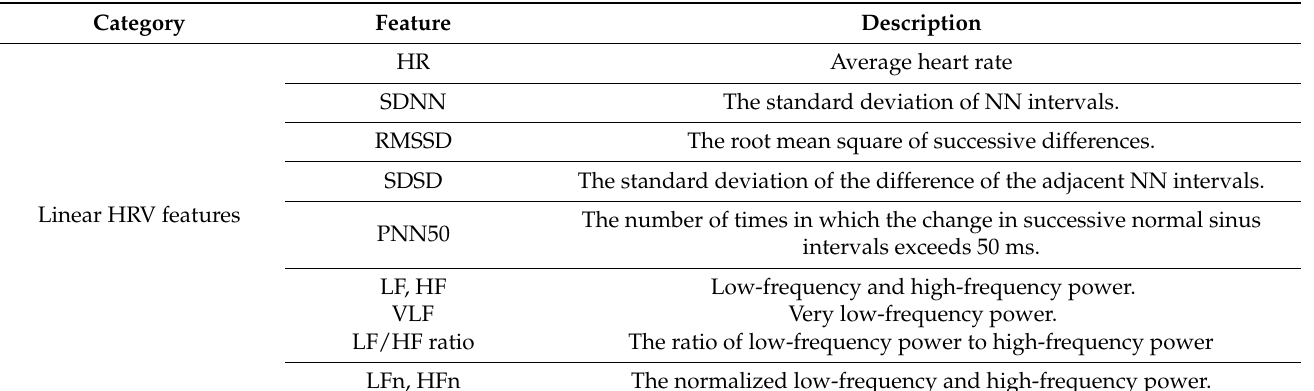
Table 1. Heart rate variability (HRV) candidate features that represent the characteristics of the data segment itself for sleep staging